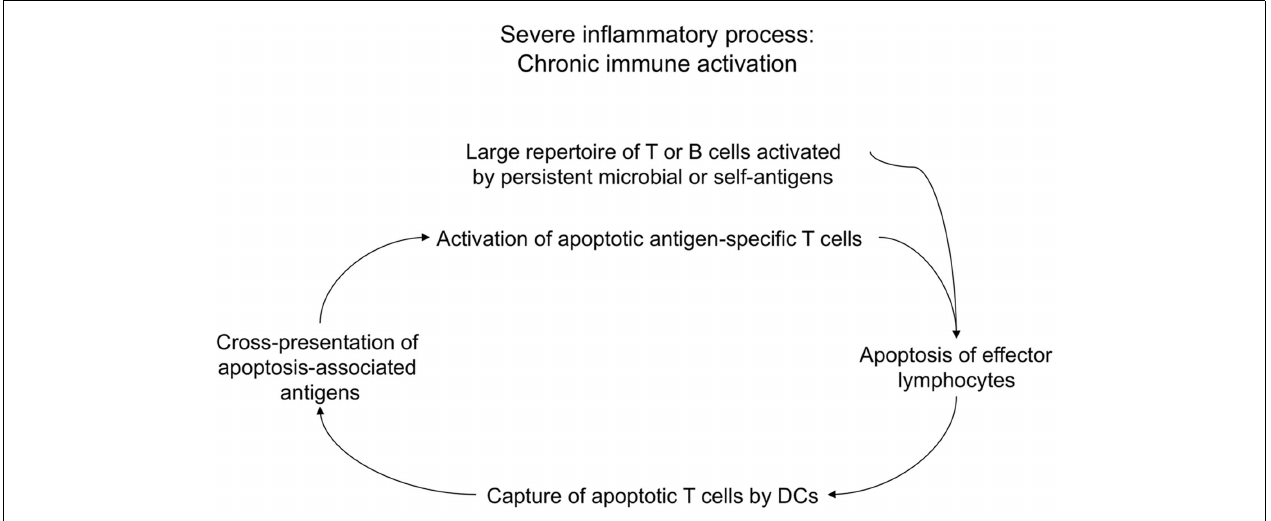
FIGURE 6 | Chronic immune activation as a result of cross-presentation of apoptoticT cells. During severe inflammatory processes, chronic immune activation may be in part maintained by a vicious spiral, which may be initiated by activated lymphocytes (e.g., specific for persistent microbial antigens or self antigens) undergoing apoptosis upon they performed their effector functions.These apoptotic cells are cross-presented by DCs, which